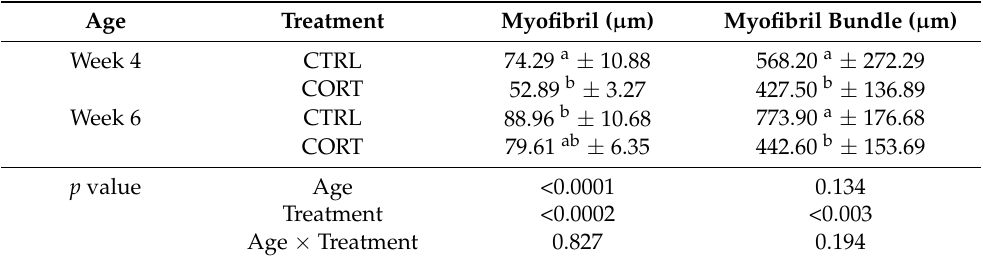
Table 6. Effect of corticosterone administration and age on muscle myofibrils and myofibril bundle diameters ( ± SD) of broiler